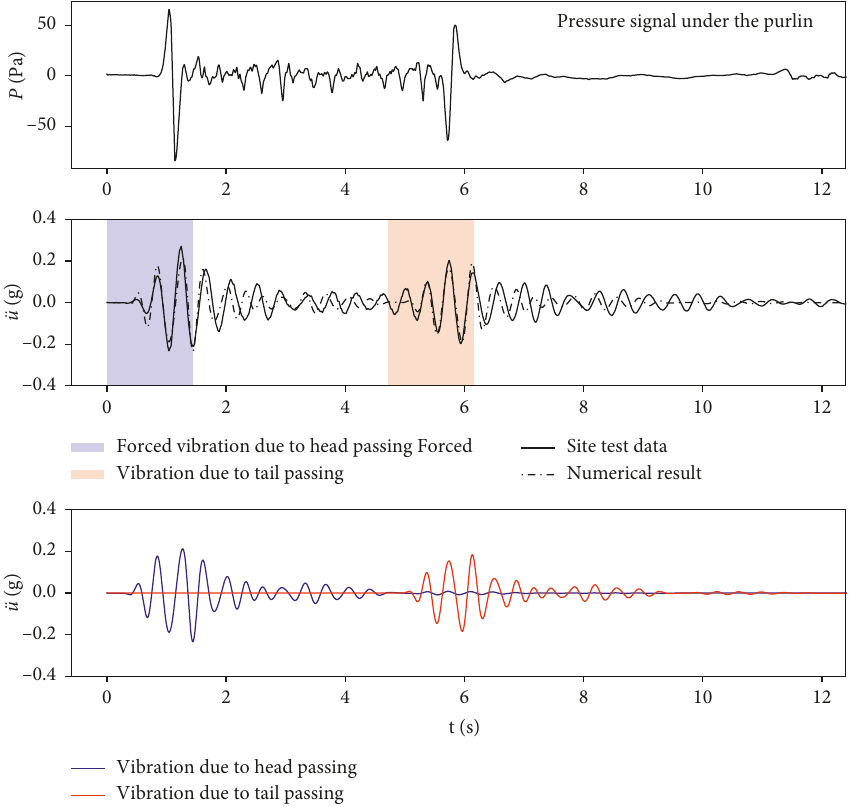
Figure 12: Pressure signal and comparison of accelerations of the purlin between site test data and numerical result for the high-speed train with speed